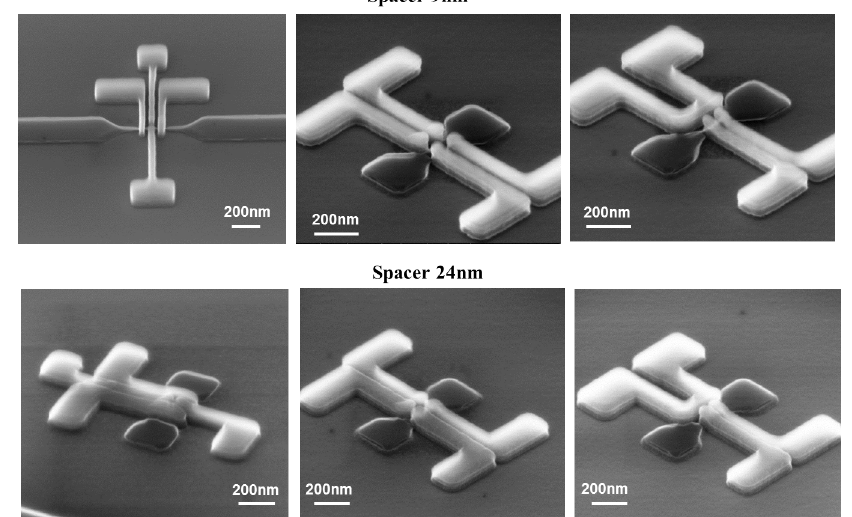
Figure 6. Examples of samples after Si source-drain epitaxy. Multi-gate devices are realized with a 65 nm gate pitch. Top : a thin spacer (9 nm) is used in order to create a silicide area between the two gates; Bottom : a thick spacer (24 nm) is used in order to avoid salicidation between the two gates.